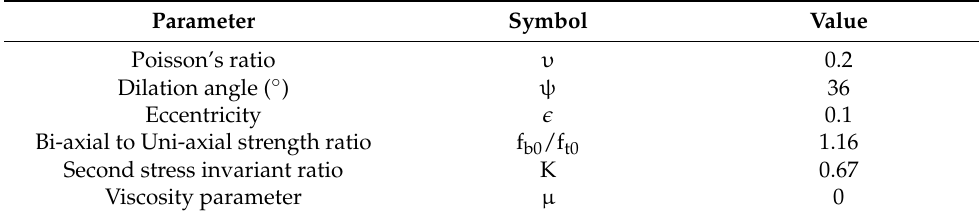
Table 2. Default parameters for numerical